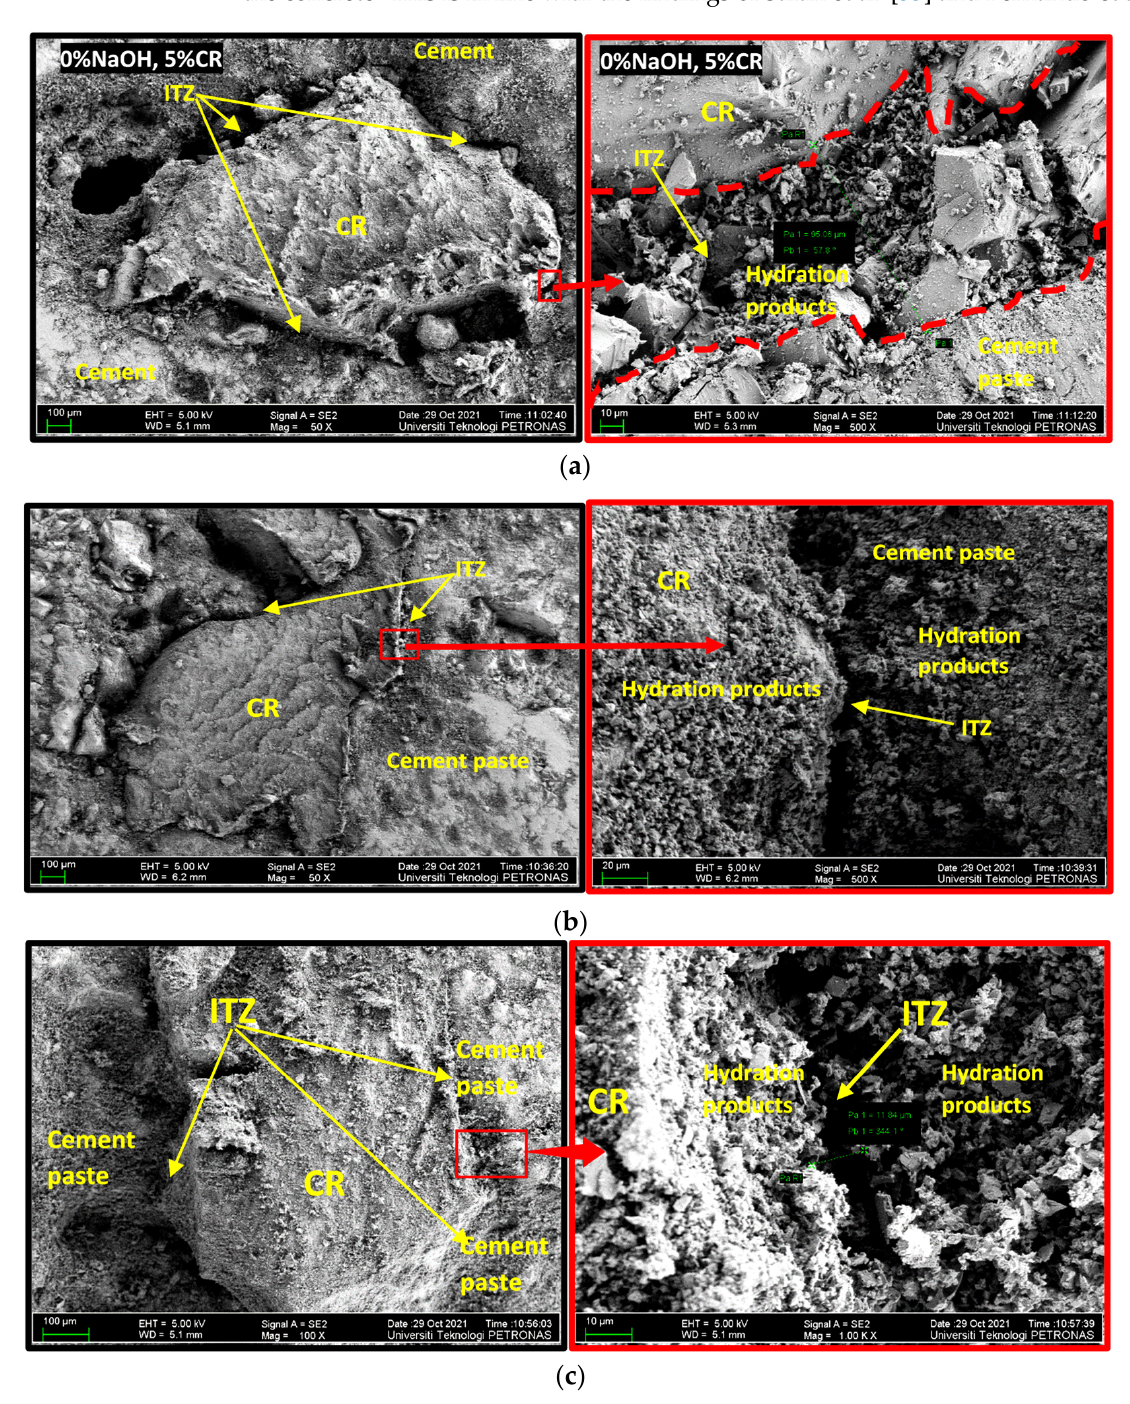
Figure 11. Field-emission scanning electron microscopy (FESEM) images for NaOH-CRC ( a ) M5(0%NaOH, 5%CR) ( b ) M7(5%NaOH, 5%CR) ( c ) M2(10%NaOH,